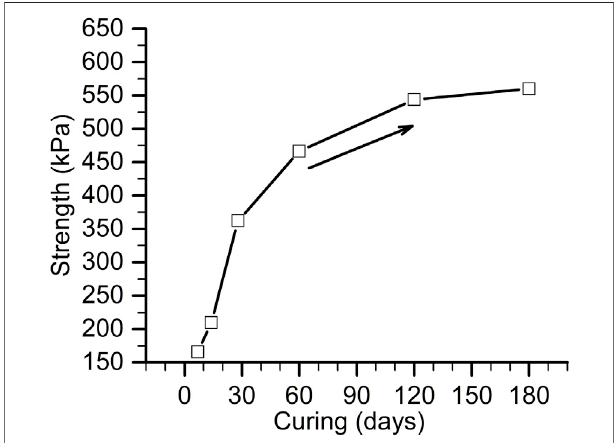
FIGURE 2 | Strength development of S/S